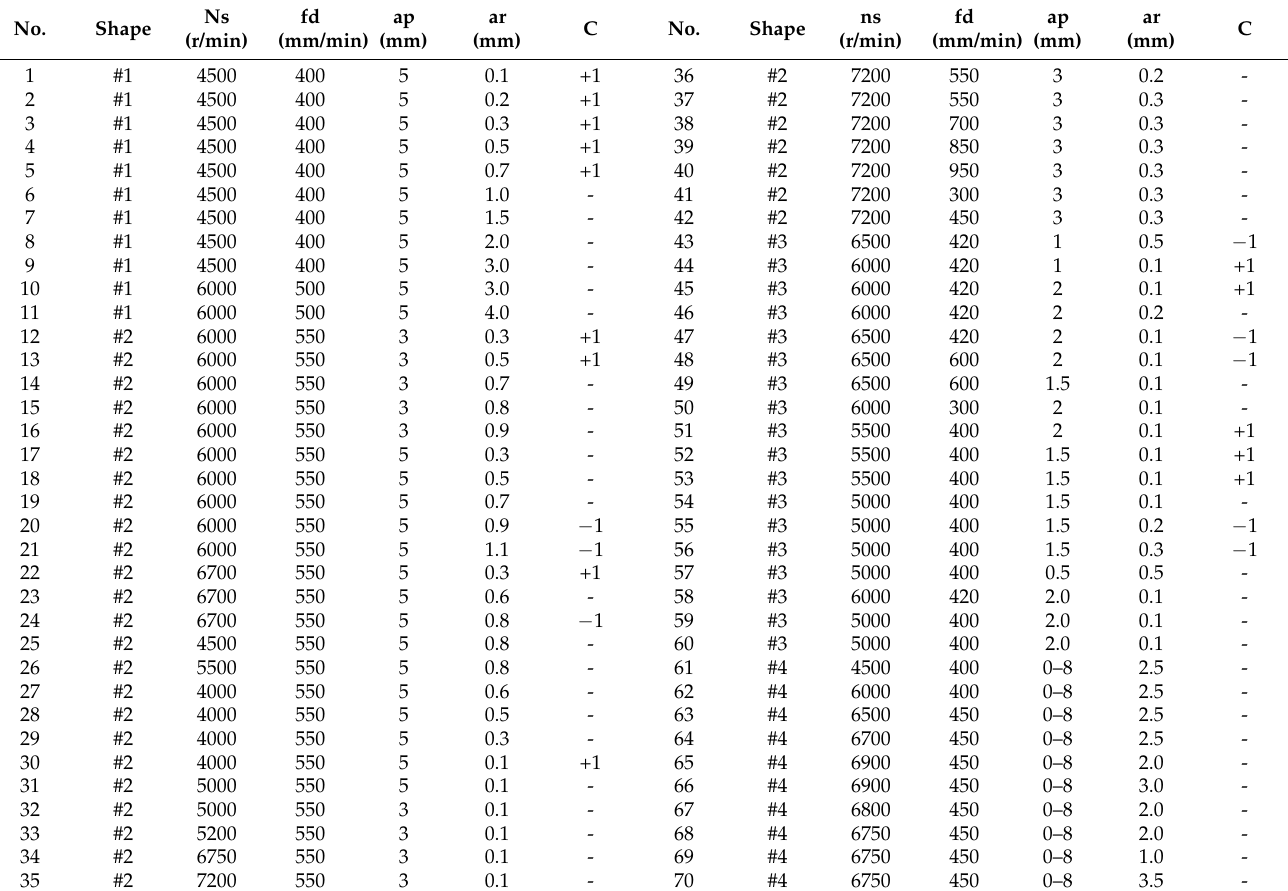
Table 3. One measure of the degree of multifractality is the width of the multifractal